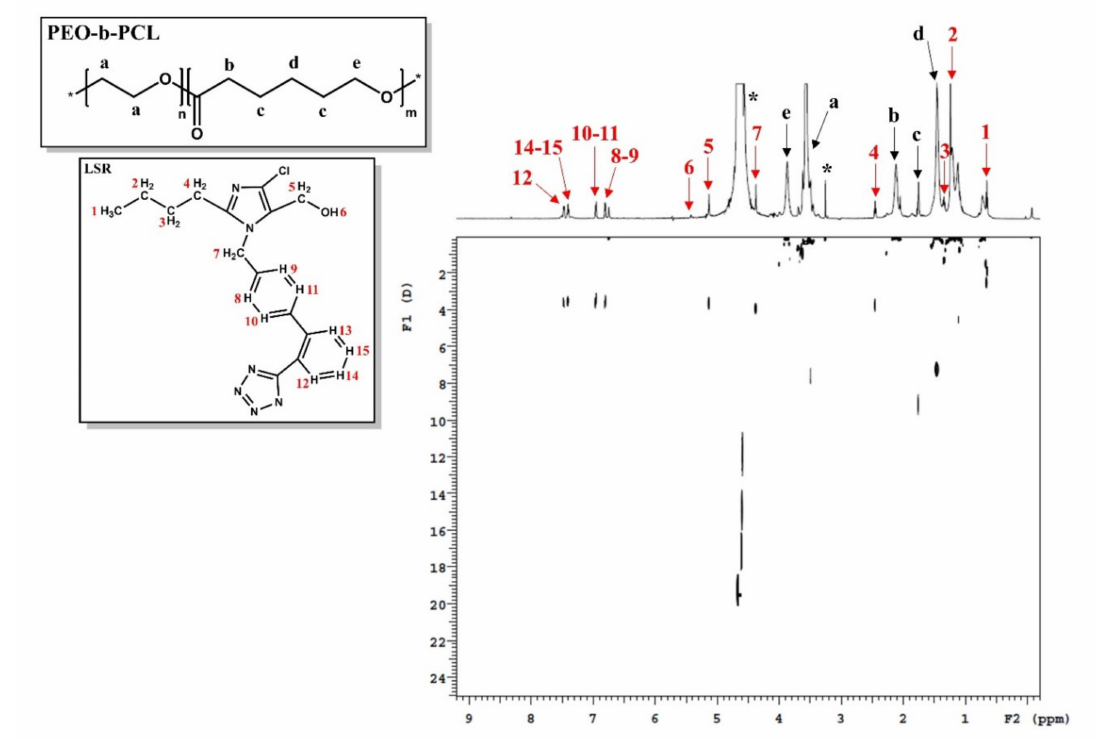
Figure 10. 2D-DOSY spectrum of PEO-b-PCL + 50% LSR nanocarriers. The black letters (a–e) denote the protons of the copolymer structure, the red letters point to the LSR peaks and the asterisk refers to the solvent D 2